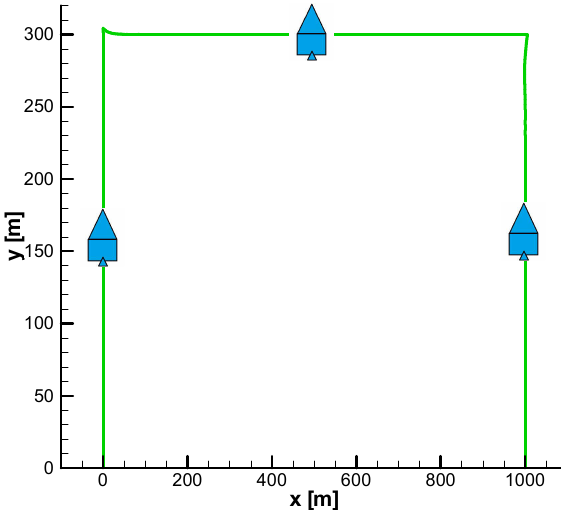
Figure 15. Vertical trajectory with horizontal flight.